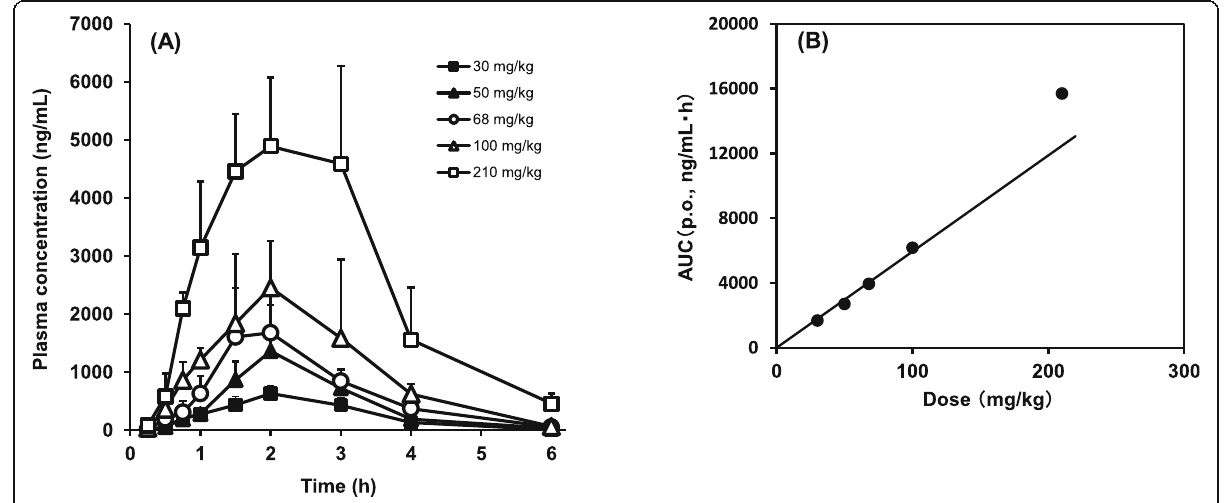
Fig. 2 Dose dependency of the pharmacokinetics of N-251 after oral administration in mice ( a ) and correlation between dose and AUC p.o ( b ). Results were expressed as mean with the bar showing the SD value. The solid lines are theoretical lines obtained in the fitting study